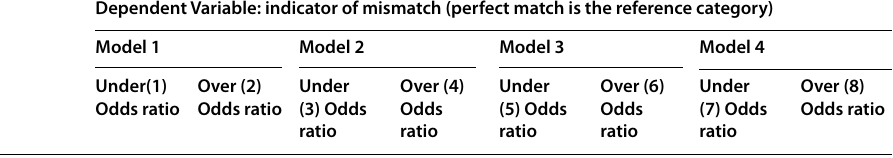
Table 5 Multinomial Logistic Regression of the Probability of Mismatch, Sample of First- and Second-Generation Workers, PIAAC